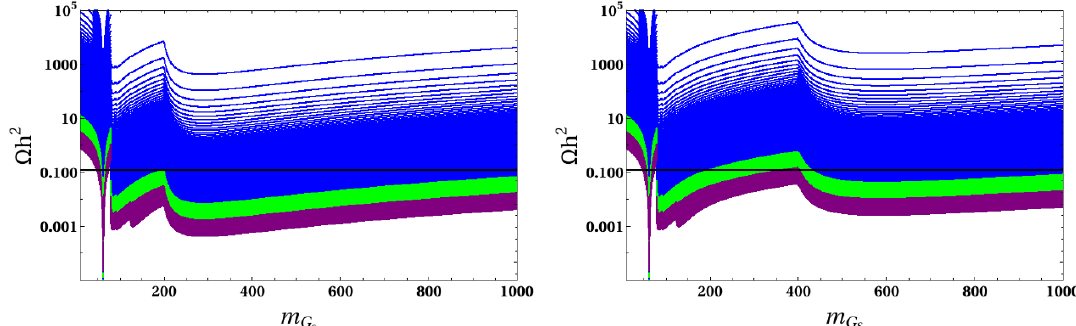
(in GeV) for (cid:21) = 0 : 005 (cid:0) 0 : 25 (blue), 0 : 25 (cid:0) 0 : 5 S